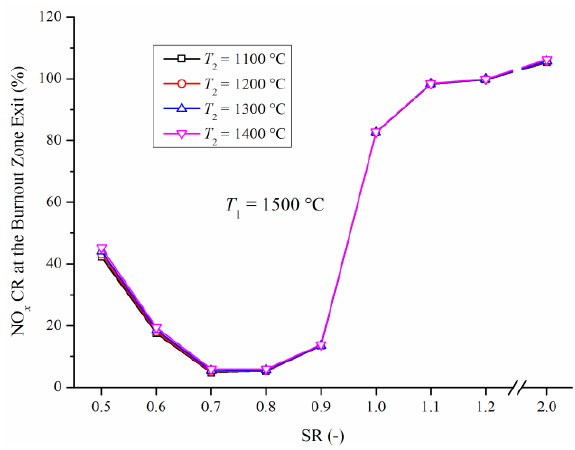
Figure 7. Effect of reaction temperature in the burnout zone on the NO x emissions in staged air combustion.